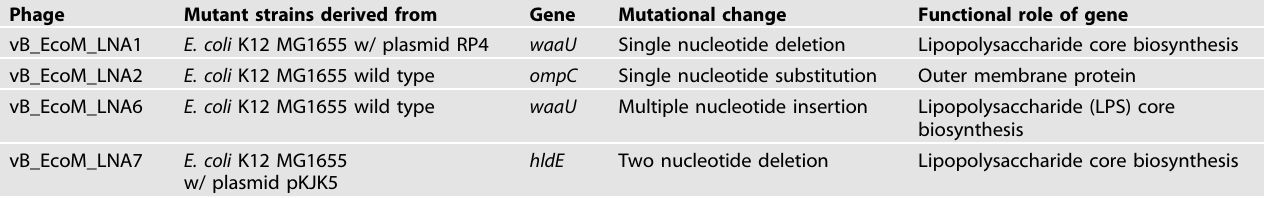
Table 3. Summary of genomic mutational changes observed in phage-resistant